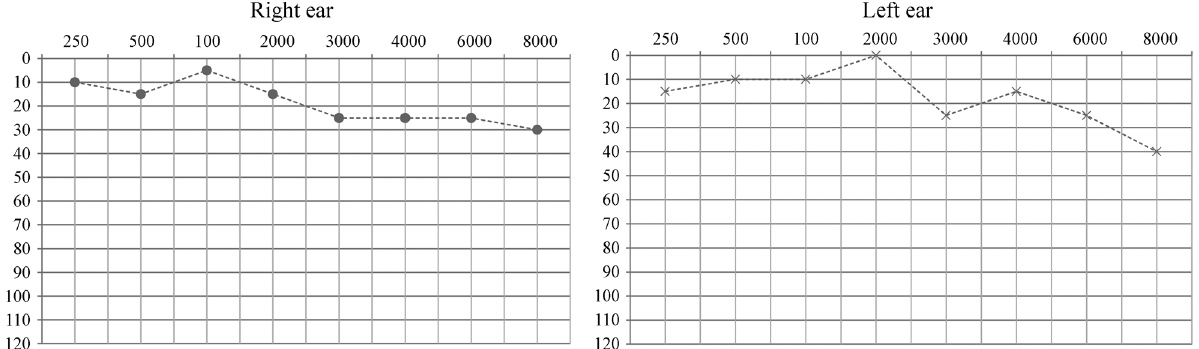
Figure 3 - Tonal audiometry showing thresholds for II-V, who presented hearing loss only in high frequencies and with onset near the age of 40.